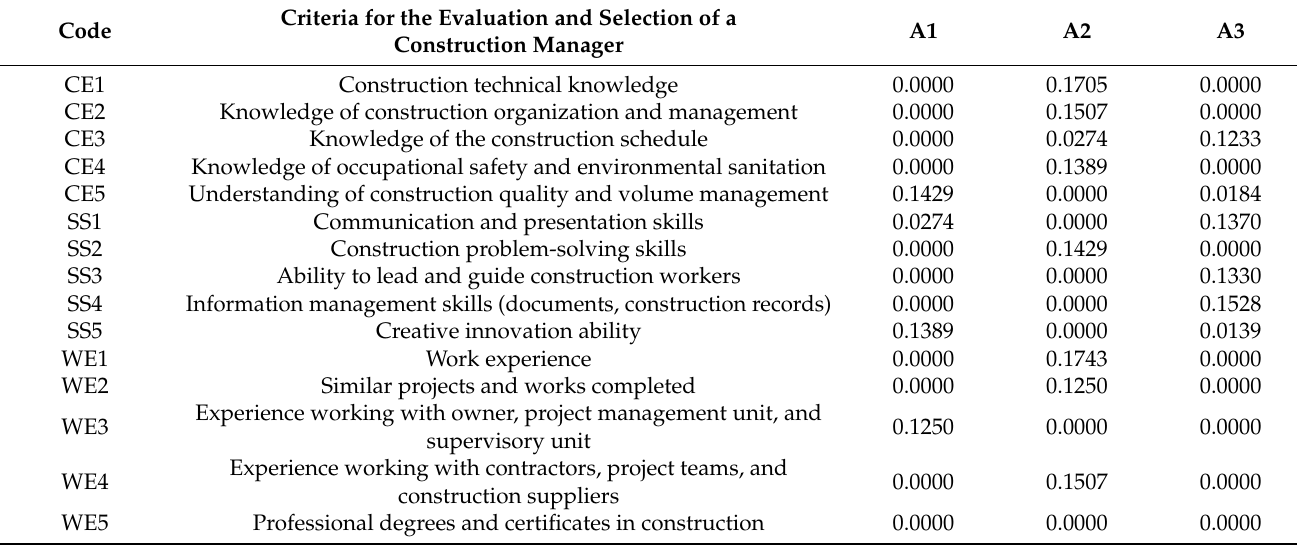
Table 5. Values of the negative distances from the average (NDA).